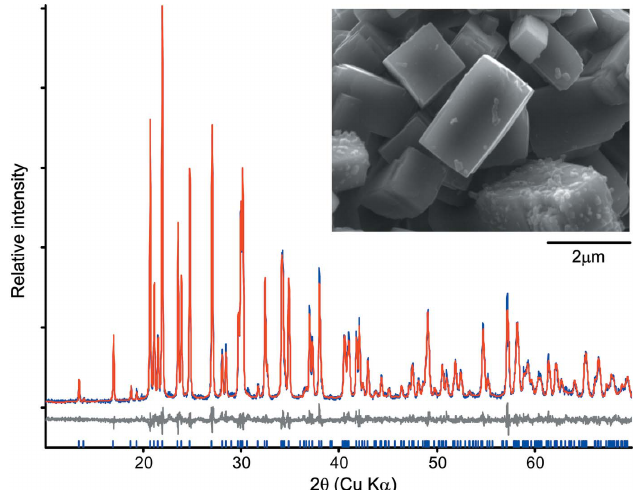
Figure 1 Powder X-ray diffraction pattern and SEM image (insert) of K-paracelsian. The blue curve is the observed data, the red curve is the Rietveld fit of the final structure model and the grey curve is the difference curve.